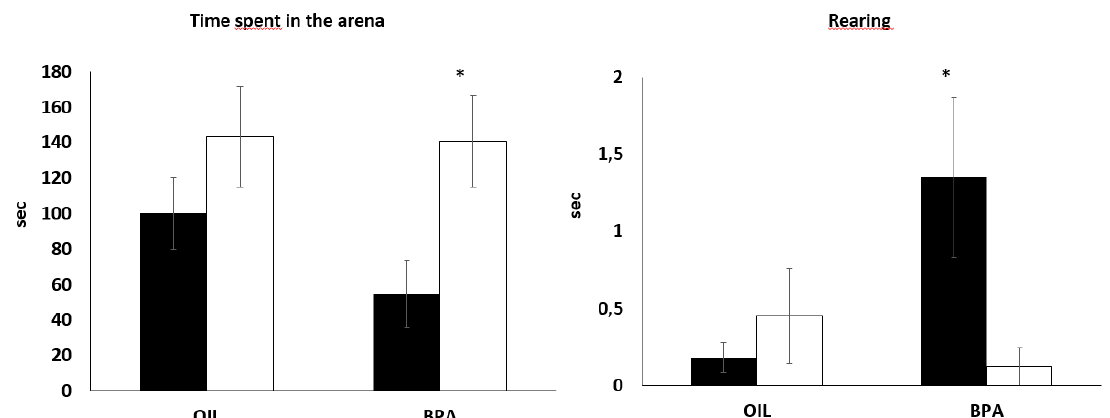
Figure 1. E ff ects of prenatal BPA exposure on behavioral responses of male and female mice in the free exploratory open field. (OIL: 14 males and 14 females; BPA: 14 males and 14 females). Dark columns = males. * p < 0.05 males vs. females BPA. Data are presented as mean ±SE.